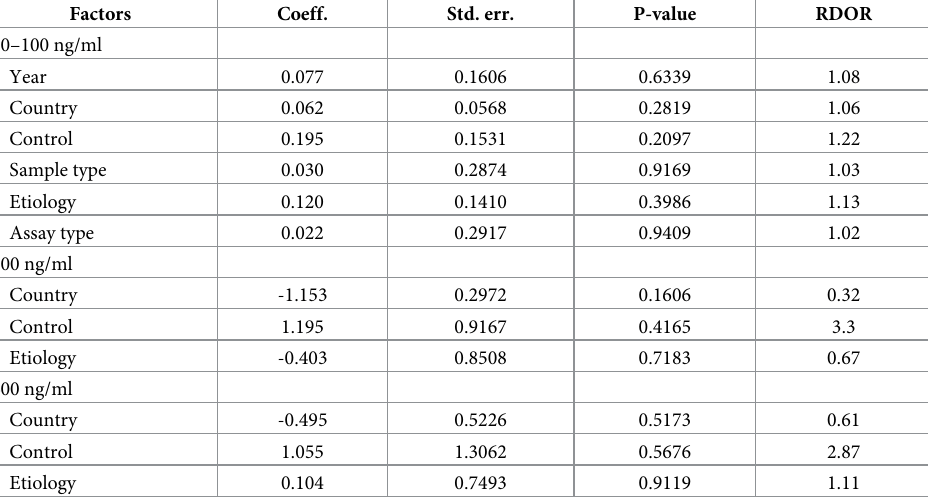
Table 6. Meta-regression analyses of potential source of